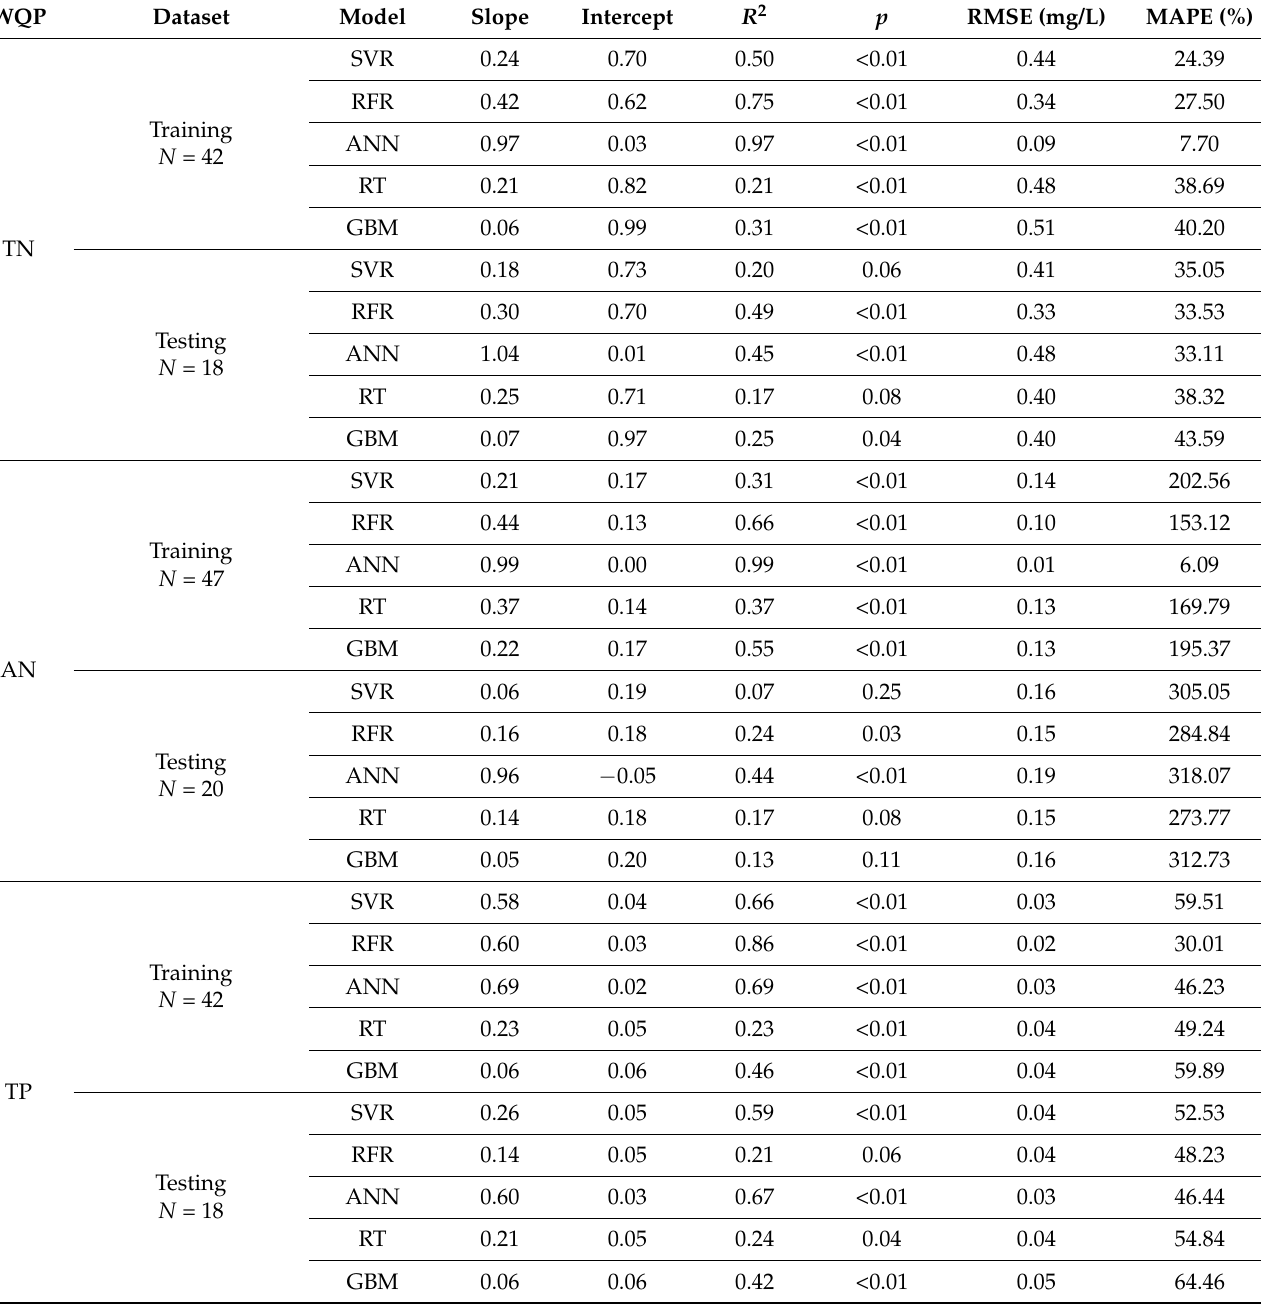
Table 2. Comparison of different machine learning algorithms for the training and testing